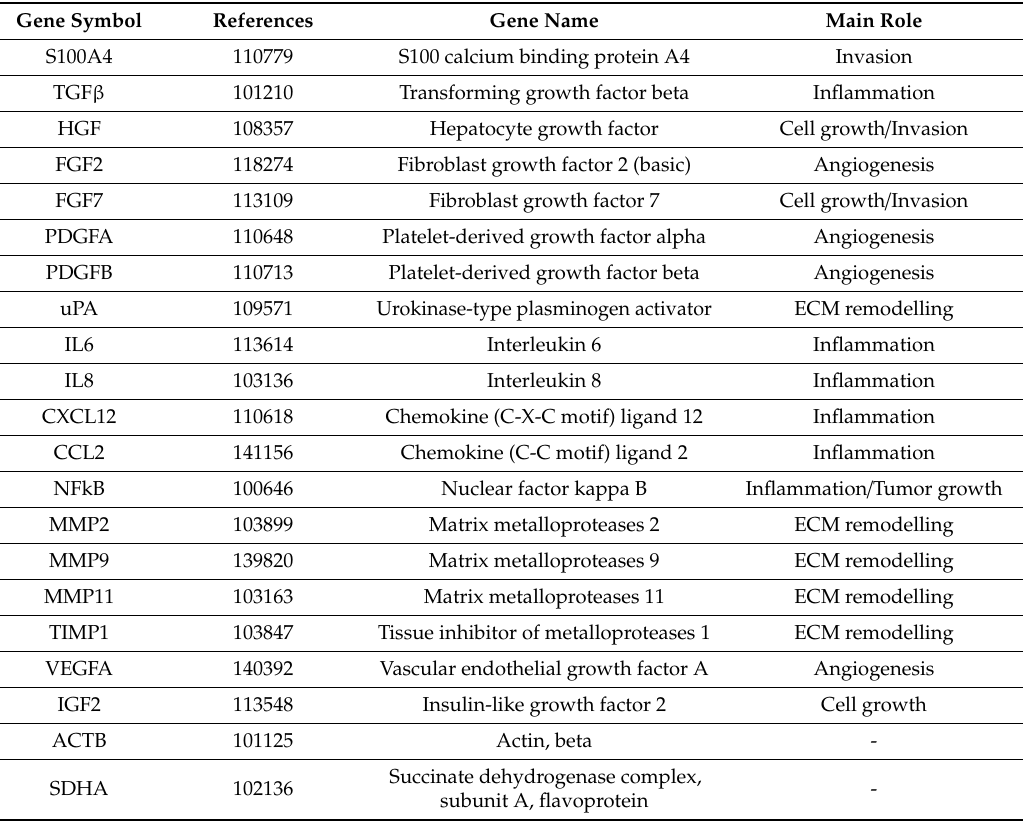
Table 2. Factors analyzed and main